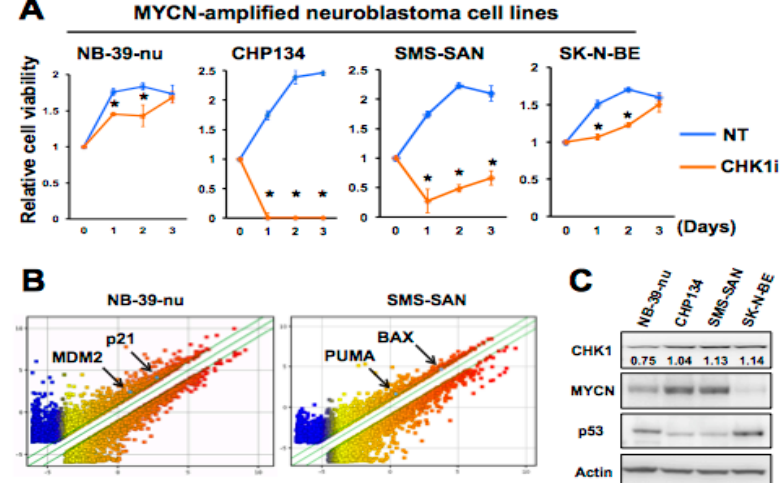
Figure 1. Checkpoint kinase 1 (CHK1) inhibition activates downstream targets of p53. ( A ) Cell viability assay of four MYCN-amplified neuroblastoma (NB) cell lines after exposure to dimethyl